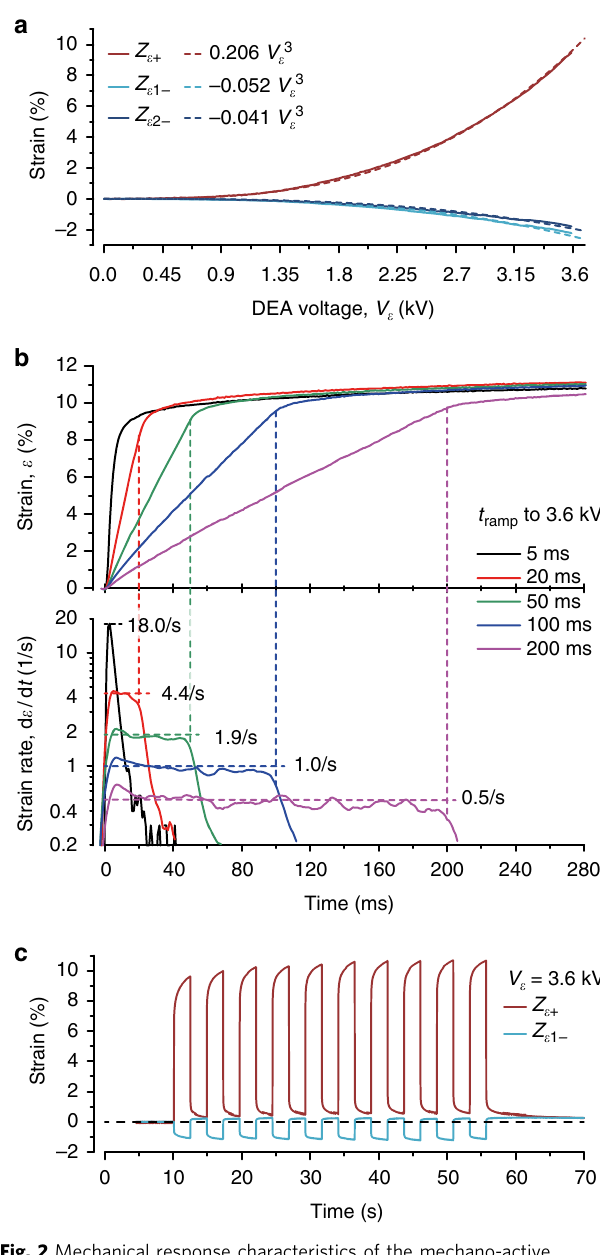
Fig. 2 Mechanical response characteristics of the mechano-active multielectrode array (MaMEA). a Plot of strain in zones Z ε + , Z ε 1 − , and Z ε V ε . The fi t shows a cubic 2 − as a function of voltage applied to the DEA, relationship. b Strain (upper panel) and strain rate (lower panel) during the fi rst 280 ms of linear ramps to ~10% strain ( V ε = 3.6 kV). The ramp time ( t ramp ) is varied from ~5 ms (step) to 200 ms. The resulting strain rates range from 18 to 0.5 s − 1 . c Example of strain pro fi les as used for the experiments. After a 10-s-long baseline recording, the strain is